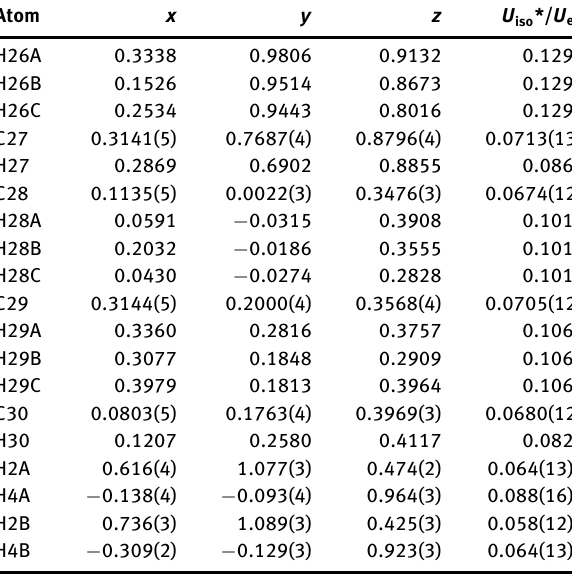
Table 2: Fractional atomic coordinates and isotropic or equivalent isotropic displacement parameters (Å 2